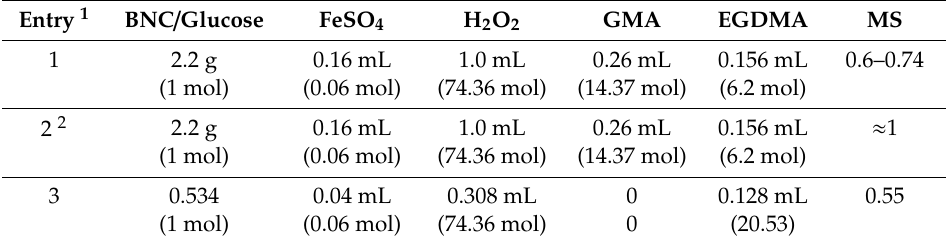
Table 3. Fenton-type GMA grafting and ethylene glycol dimethacrylate (EGDMA) cross-linking in function of the reagent